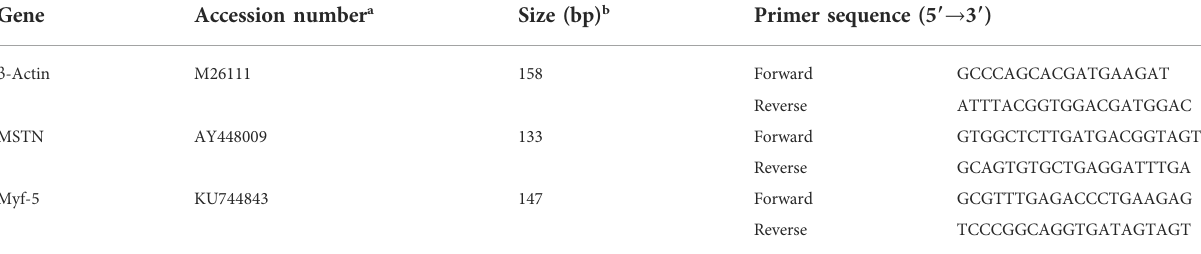
TABLE 2 Primers used for quantitative real-time